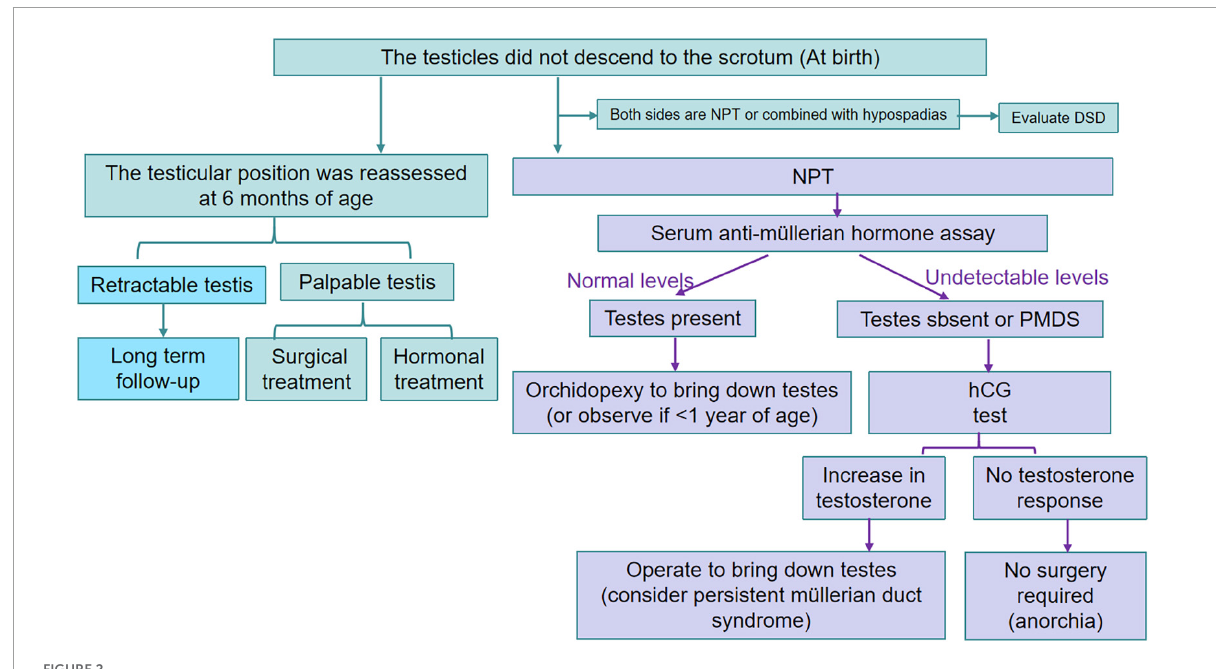
FIGURE2 Flow chart of diagnosis and treatment of